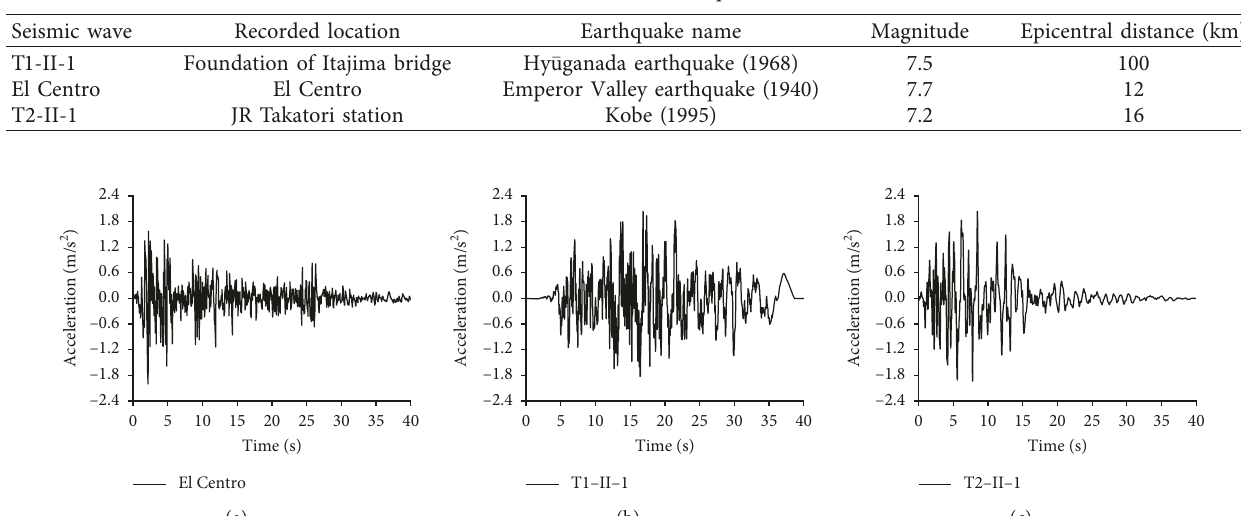
Table 3: Parameters of the earthquake motions.